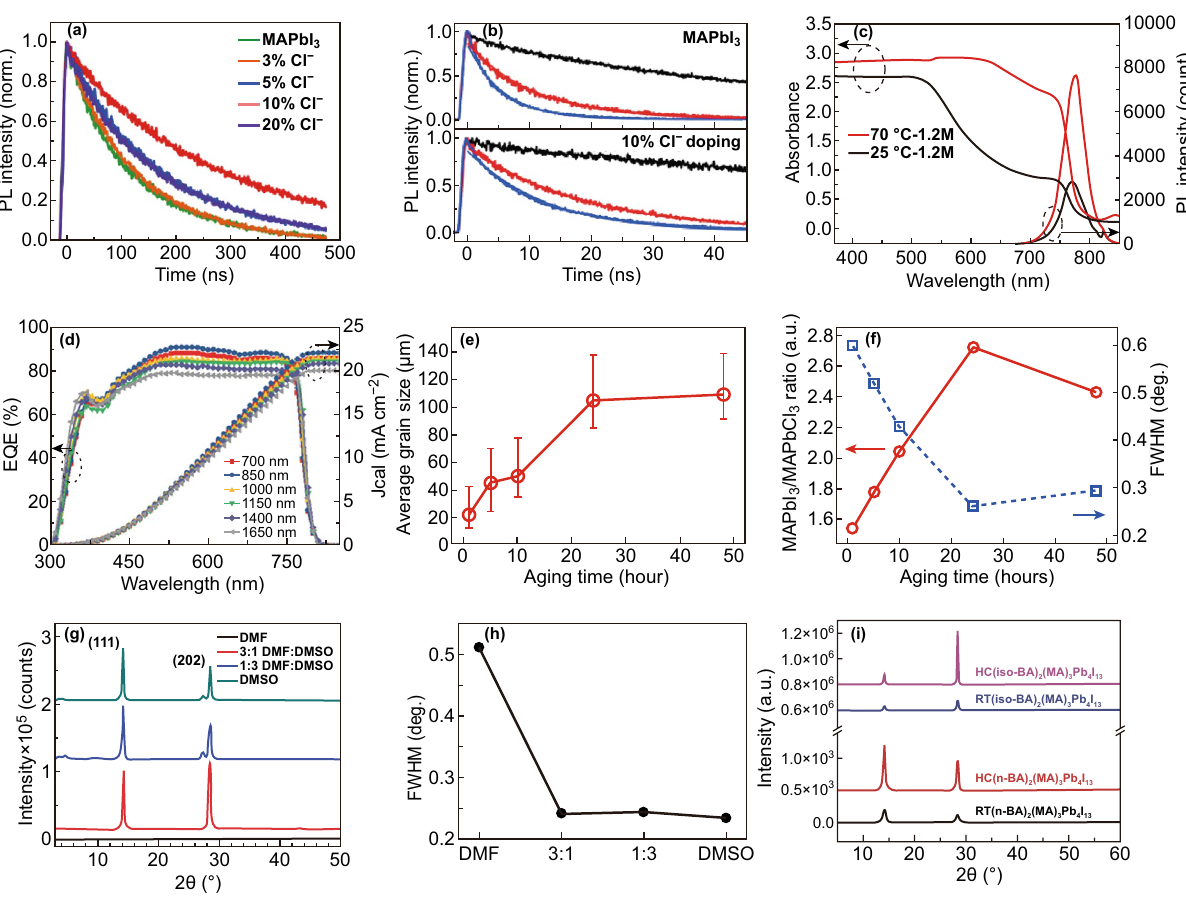
Fig. 3 a TRPL curves for a pristine perovskite film and with different chlorine contents. b TRPL curves for pristine perovskite films (black) in conjunction with a hole quencher (red) and an electron quencher (blue) [11]. Copyright © 2016 WILEY-VCH Verlag GmbH & Co. KGaA, Weinheim. c Absorption spectra and steady-state PL emission spectra of MAPbI 3 perovskite films fabricated at different casting temperatures of 25 °C and 70 °C. d EQE spectra for perovskite solar cells with varying active layer thicknesses through hot cast [53]. Copyright © 2016 WILEY-VCH Verlag GmbH & Co. KGaA, Weinheim. e Average grain size with error bar determined for 1–48 h aging time. f Peak ratio of MAPbI 3 /MAPbCl 3 as a function of aging time and FWHM of MAPbI 3 peak (2 θ = 14.28°) [46]. Copyright © 2017 WILEY-VCH Verlag GmbH & Co. KGaA, Weinheim. g XRD patterns as a function of peak intensity versus 2θ (degree) of the hot-cast BA 2 MA 4 Pb 5 I 16 films from pre- cursor solutions using DMF, DMSO, and mixed solvents. h FWHM of the (111) reflection as a function of precursor solvent used for thin- film fabrication [17]. Copyright © 2017 WILEY-VCH Verlag GmbH & Co. KGaA, Weinheim. i XRD patterns of RT and hot-cast fabricated (n-BA) 2 (MA) 3 Pb 4 I 13 and (iso-BA) 2 (MA) 3 Pb 4 I 13 perovskites [18]. Copyright © 2019 Elsevier